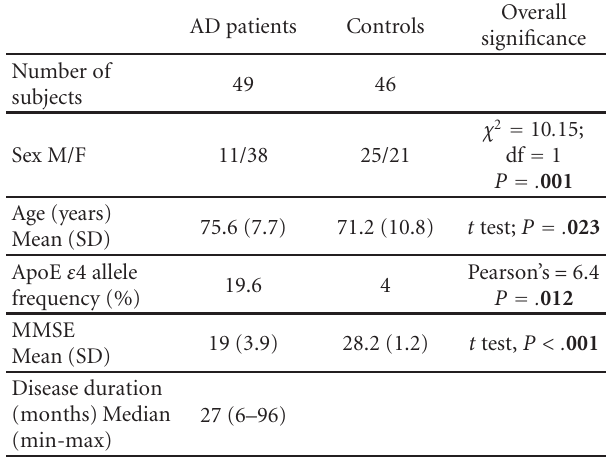
Table 1: Characteristics of the study